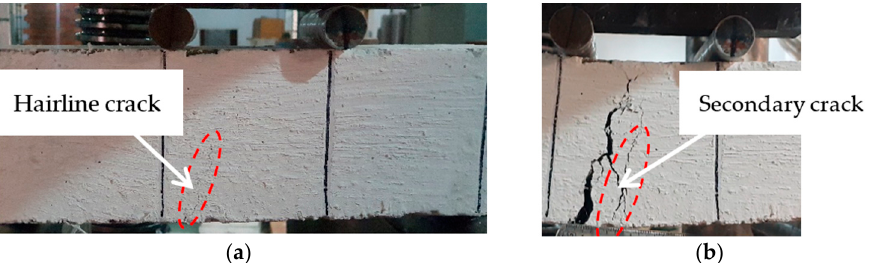
Figure 10. Cracking in the specimen incorporating 20 kg/m 3 of PP fibers: ( a ) first hairline crack, ( b ) secondary crack.